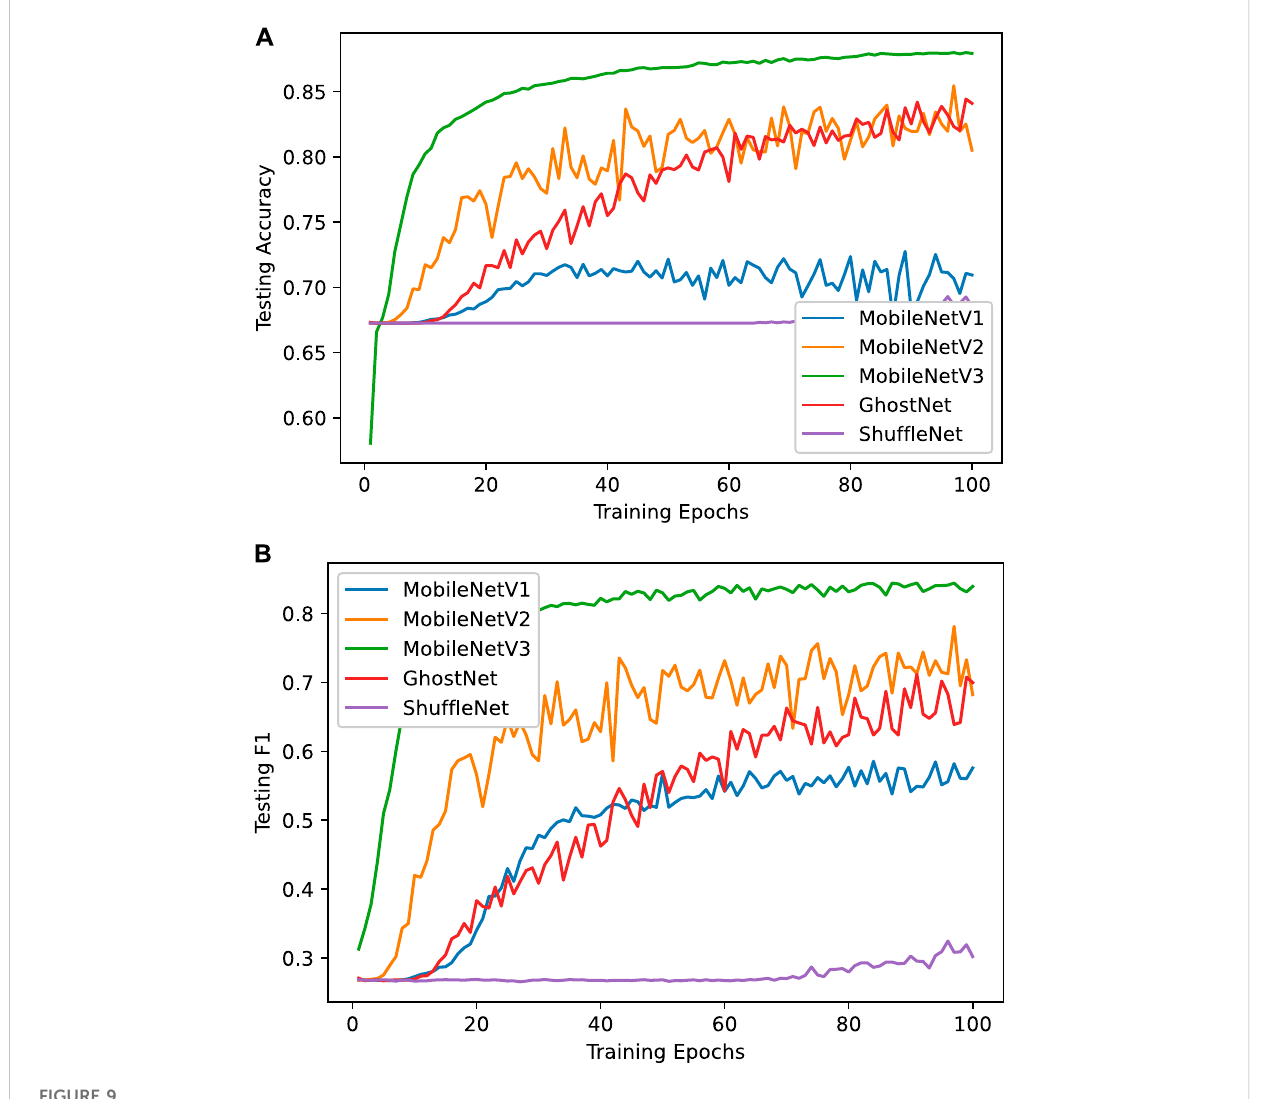
FIGURE 9 Testing set validation over different epochs: (A) accuracy and (B) F1-Score.